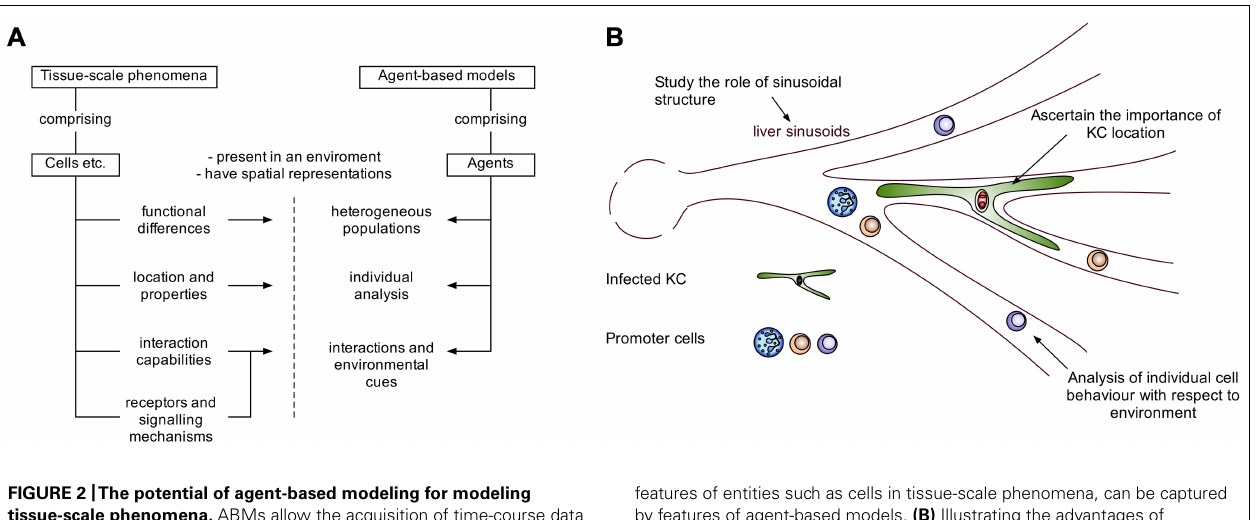
features of entities such as cells in tissue-scale phenomena, can be captured by features of agent-based models. (B) Illustrating the advantages of agent-based modeling in the context of hepatic granuloma